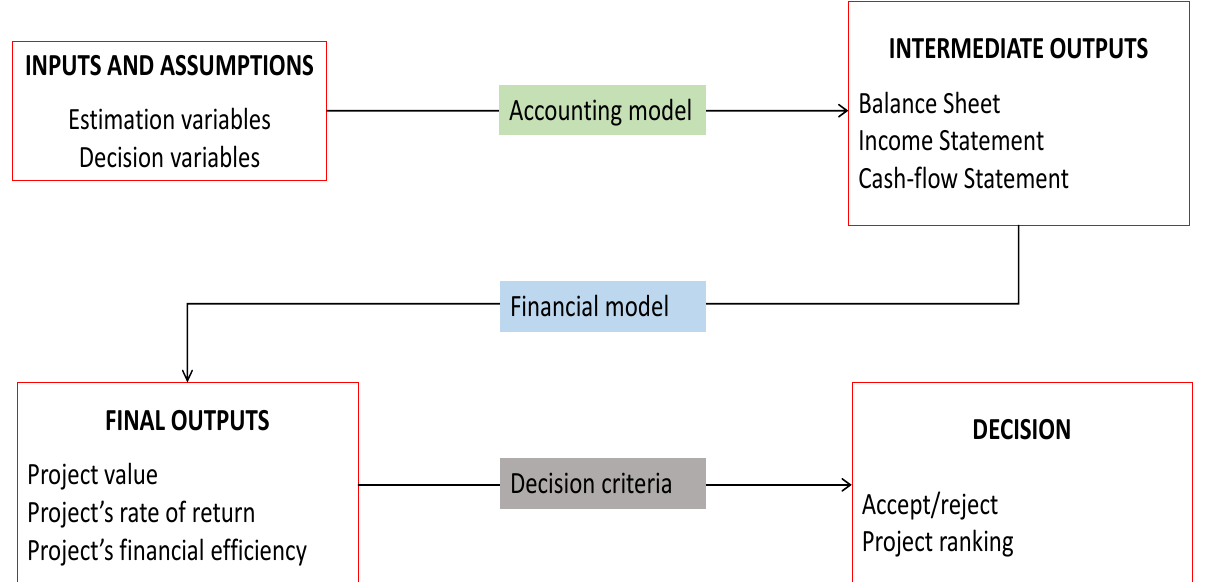
Figure 1. Model structure for a capital asset